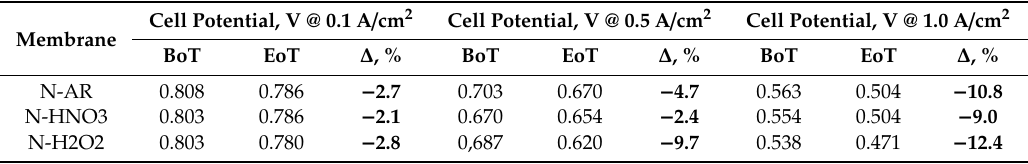
Table 3. Cell voltage and percentage variation ∆ obtained at Beginning of Test (BoT) and End of Test (EoT) at three di ff erent current densities.